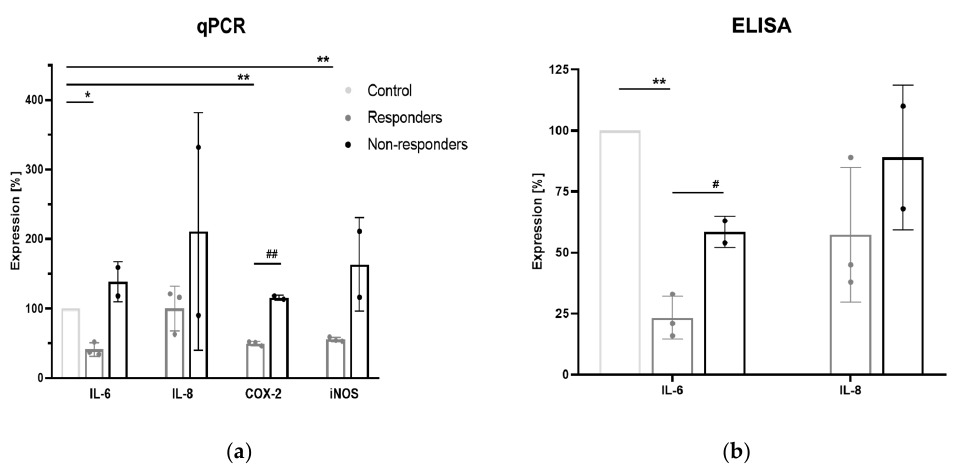
Figure 2. Expression of IL-6, IL-8, COX-2, and iNOS after Toll-like receptor (TLR)2/4 inhibition in IVD cells. The light grey columns display the control (IVD cells with C. acnes infection but without sparstolonin B treatment), whereas responders are colored in grey and non-responders in black (responders: n = 3, non-responders: n = 2). (a) Gene expression levels of qPCR results (b) Protein expression levels obtained with ELISA. * p < 0.05 relative to control, ** p < 0.01 relative to control, # p < 0.05 between responders and non-responders, ## p < 0.01 between responders and non-responders. Data are shown in mean with SD.